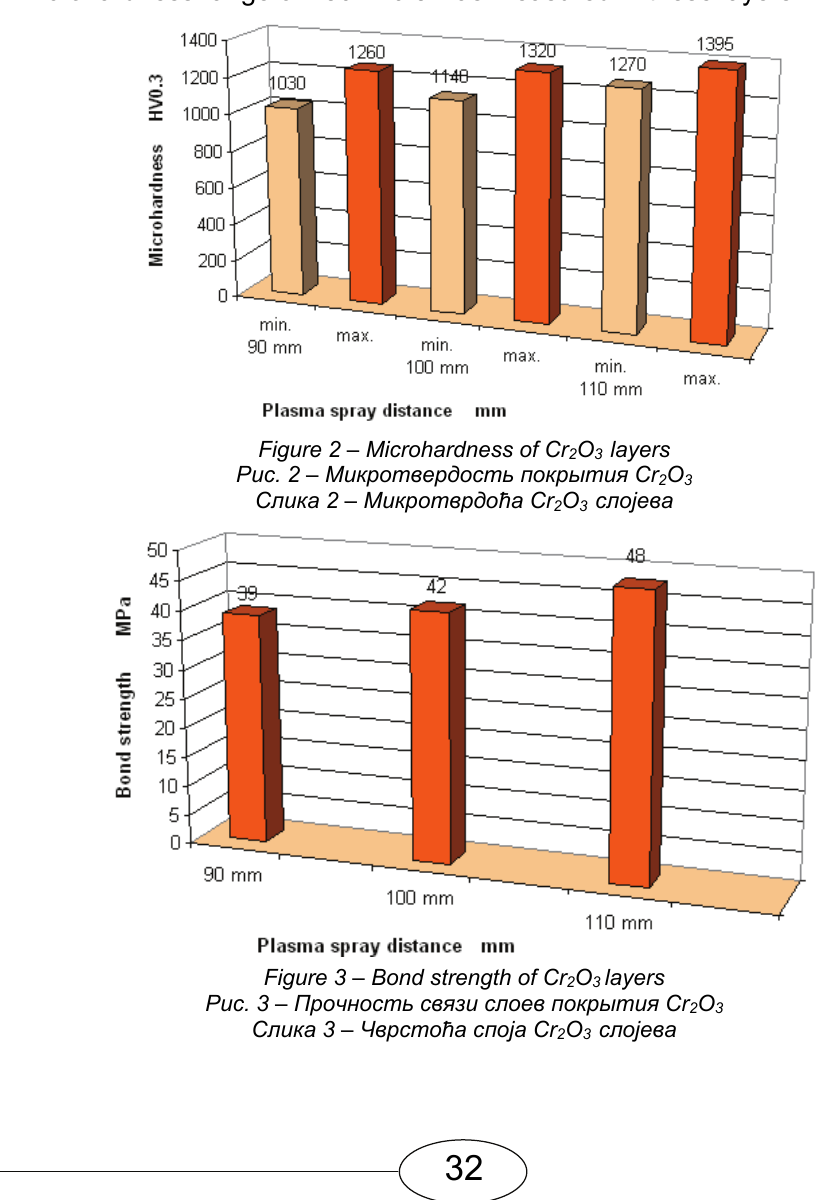
Figure 3 – Bond strength of Cr 2 O 3 layers Рис . 3 – Прочность связи слоев покрытия Cr 2 O 3 Слика 3 – Чврстоћа споја Cr 2 O 3